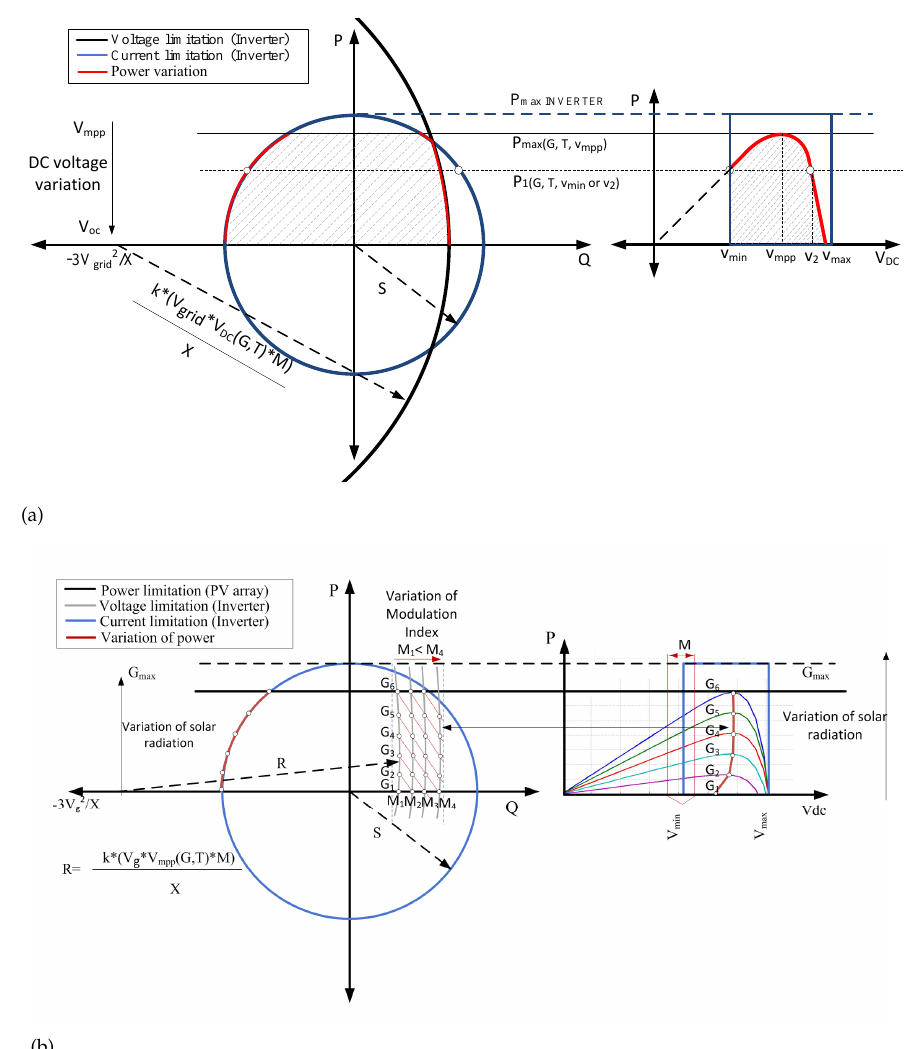
Figure 14. PQ capability curve of a PV generator ( a ) Variable dc voltage ( b ) Variable Modulation index [30] (Reproduced from Solar Energy, Vol 140, Ana Cabrera et al., “Capability curve analysis of photovoltaic generation systems”, Copyright (2016), with permission from